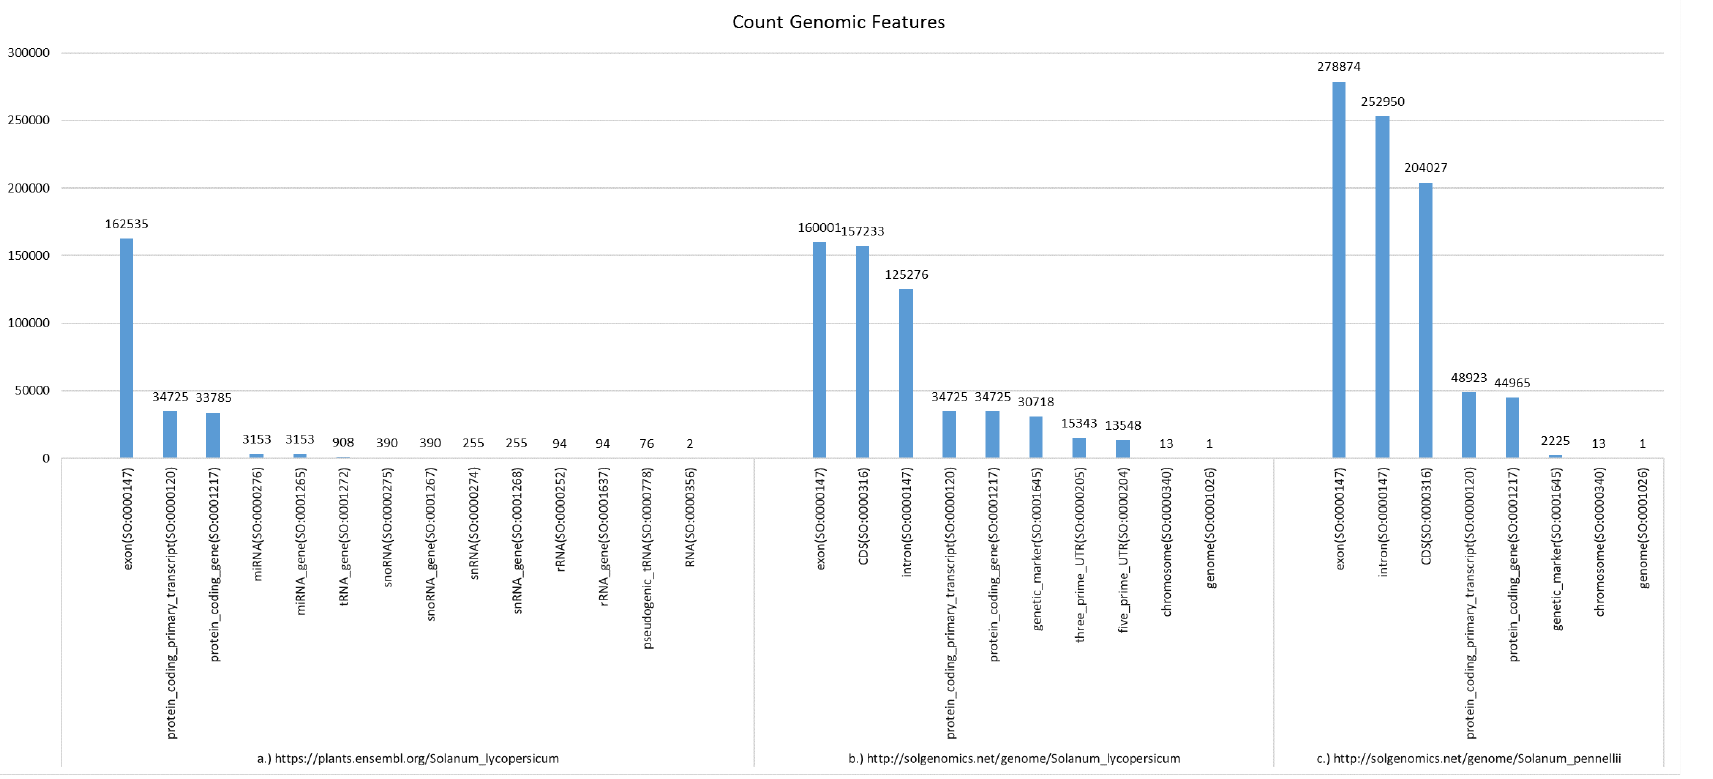
Figure 5. Bar charts of genomic feature counts for three Solanum genomes (graph IRIs): Ensembl: S. lycopersicum (http://plants.ensembl.org/Solanum_lycopersicum); SGN: S. lycopersicum (http://solgenomics.net/genome/Solanum_lycopersicum); SGN: S. pennellii (http://solgenomics.net/genome/Solanum_pennellii). The data were obtained through the pbg-ld Web API /countFeatures